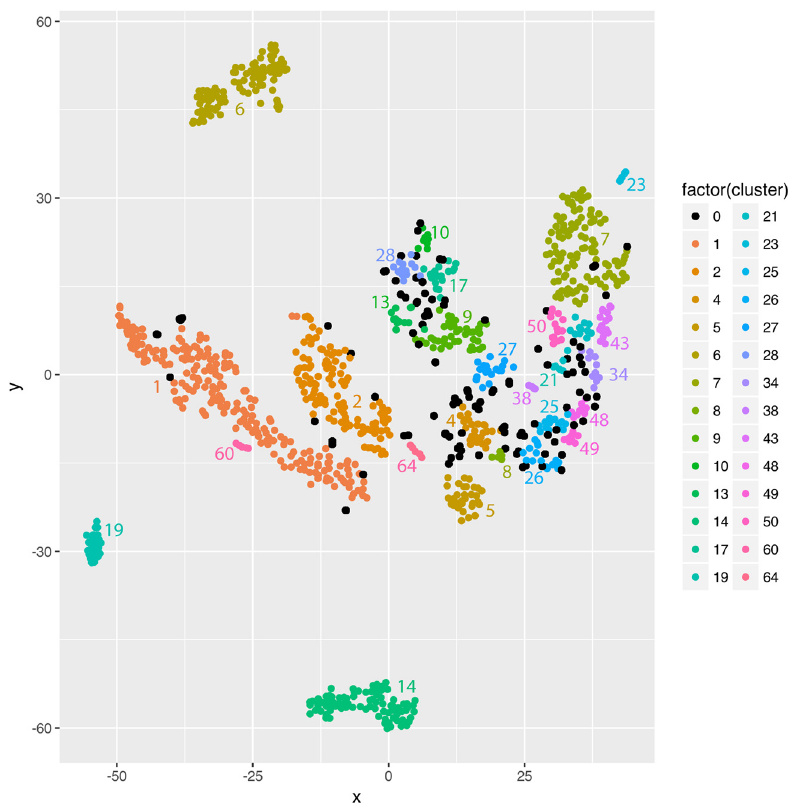
Figure 6: Representation of the 1st hierarchy level ( main cluster ) of the HDBSCAN cluster analysis on the two - dimensional t - SNE visualization; data points identi fi ed as noise are indicated in black ( cluster 0 ) ( fi gure: M. Hinz )